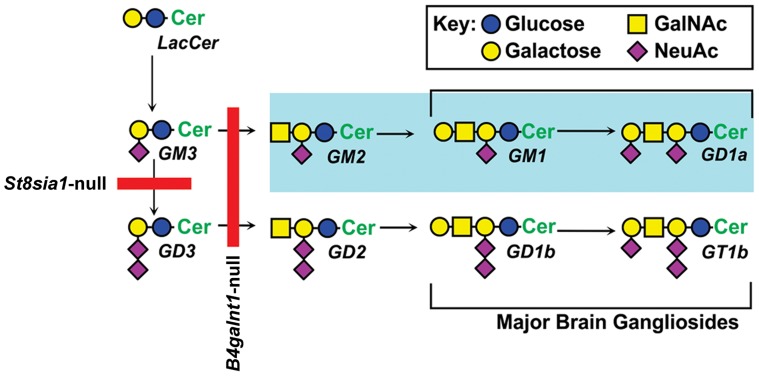
Scheme of biosynthetic pathways for major nervous system gangliosides.Blockades in ganglioside biosynthesis in knockout mice are indicated by solid red lines. GM2/GD2-synthase knockout mice (B4galnt1-null) mice do not express any complex gangliosides, including GM1, GD1a, GD1b or GT1b, and express only simple gangliosides GM3 and GD3. GD3-Synthase knockout mice (St8sia1-null), which lack the GD3 synthase required for synthesis of b-series gangliosides, overexpress a-series gangliosides (highlighted), particularly GM1 and GD1a, and do not express b-series gangliosides GD3, GD2, GD1b, and GT1b.